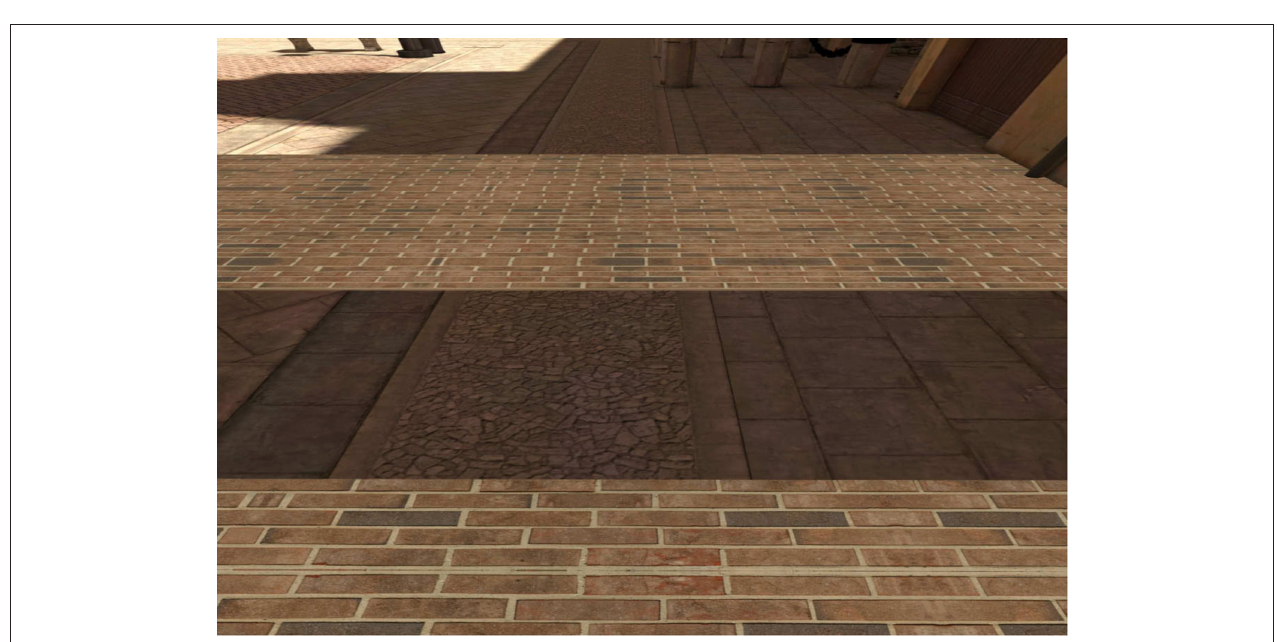
FIGURE 2 | An example of a gap on the ground. The viewer stood with their toes at the edge of the near brick surface and judged stepping so that their heel would touch the far brick surface.